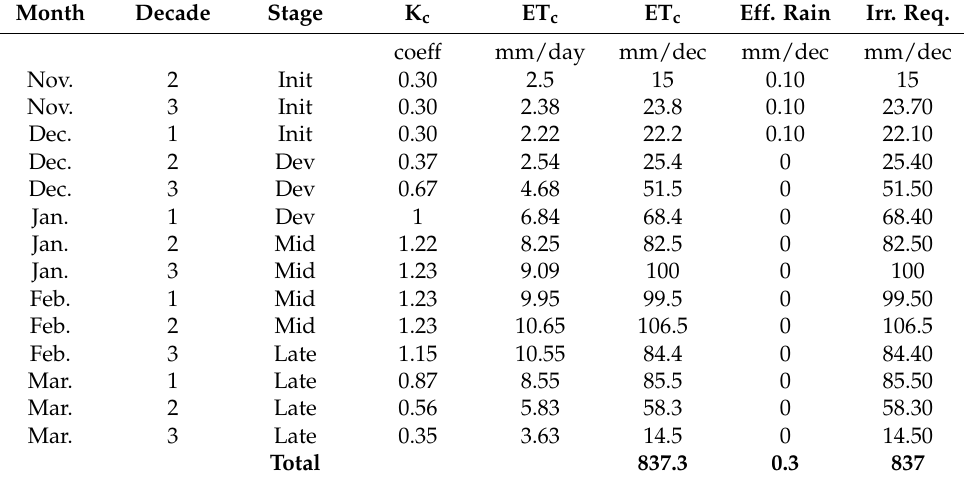
Table 4. Crop water requirements for